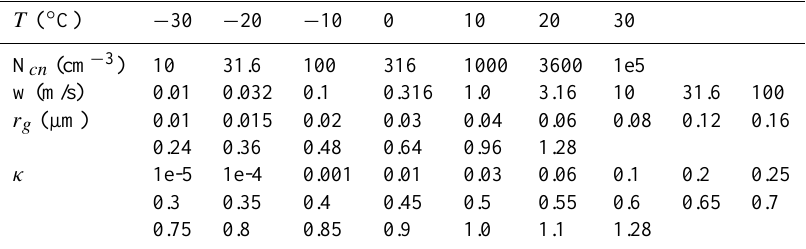
Table 1. Initial values for the parcel model